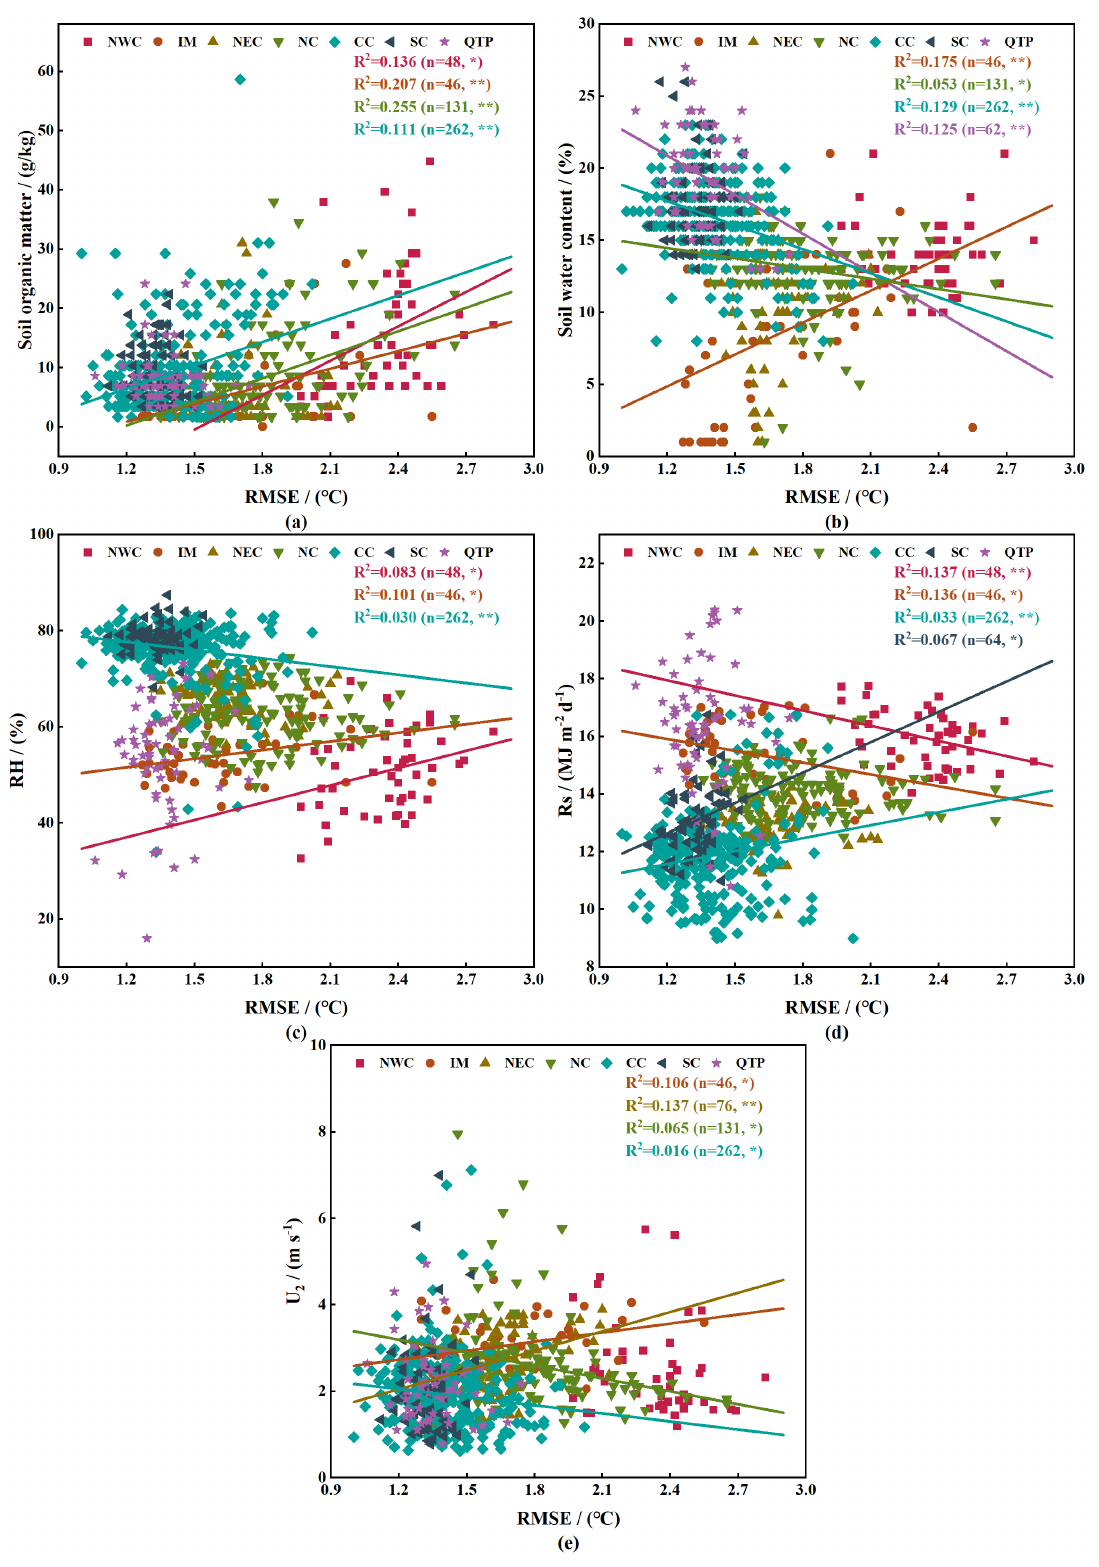
Figure 6. Fitting relationships between several factors (( a ) soil organic matter; ( b ) soil water content; ( c ) RH; ( d ) R s ; ( e ) U 2 ) and model performance in estimating T s (* indicates significant correlation. ** indicates highly significant correlation.).